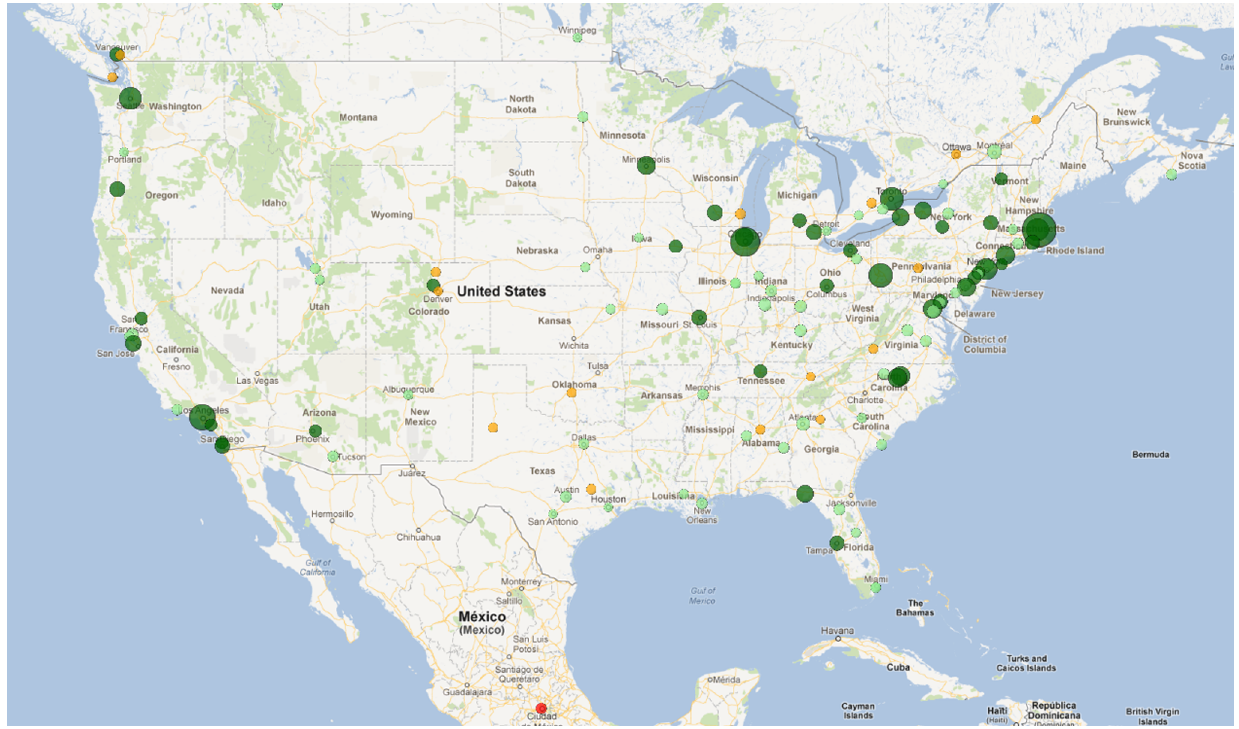
Figure 2. Cities in the USA with highly cited articles in psychology during 2007 (only cities are visualized with a total article output in 2007 of at least 50)